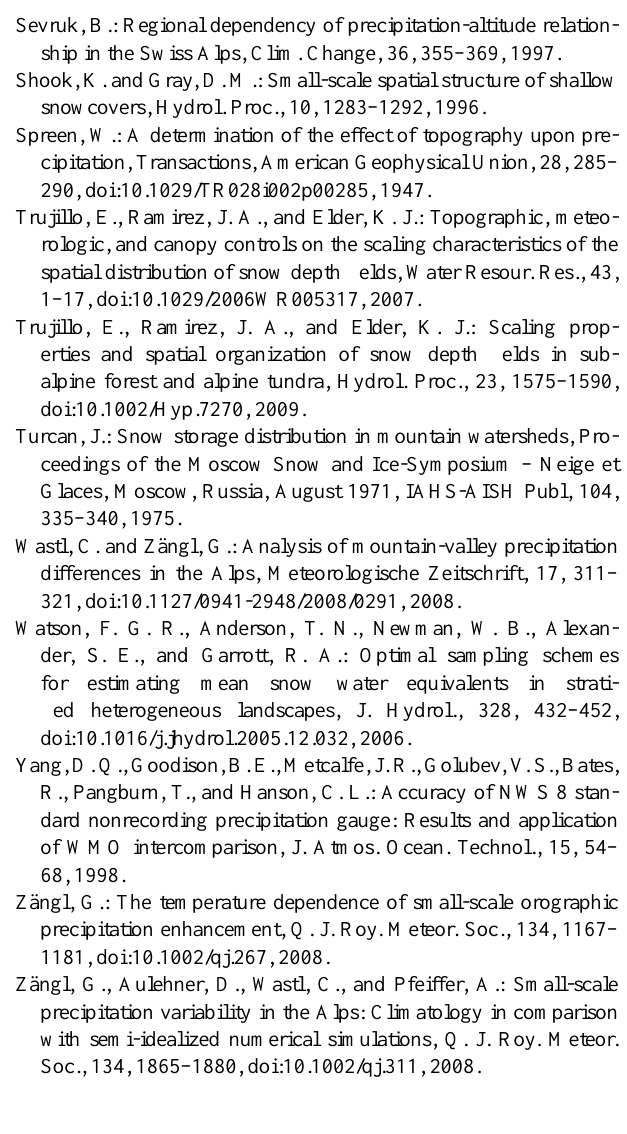
I Figueras, P., and Talaya Lopez, J.: Snowpack depth modelling and water availability from LIDAR measurements in